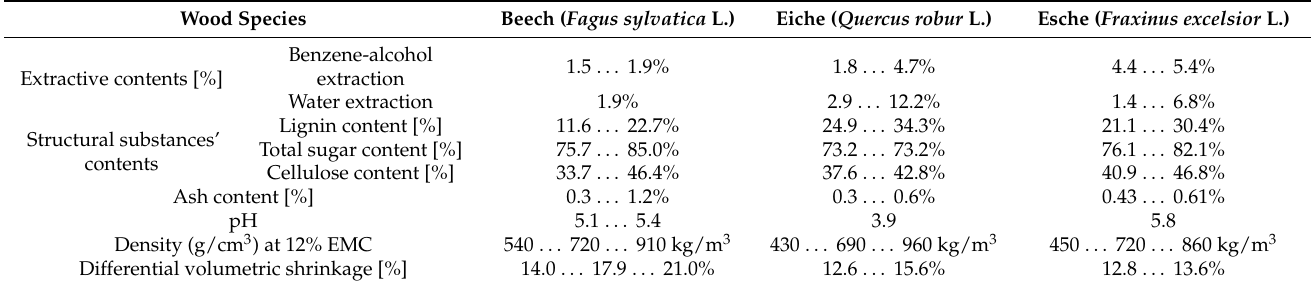
Table 1. Summary of the properties of beech wood, in comparison with the selected deciduous trees [32].